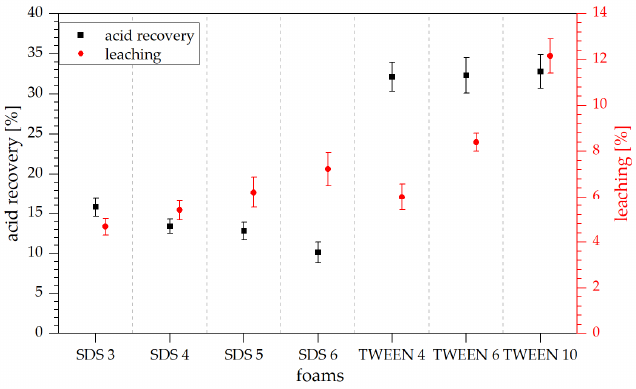
Figure 8. Acid recovery and leaching results of the tannin foams.